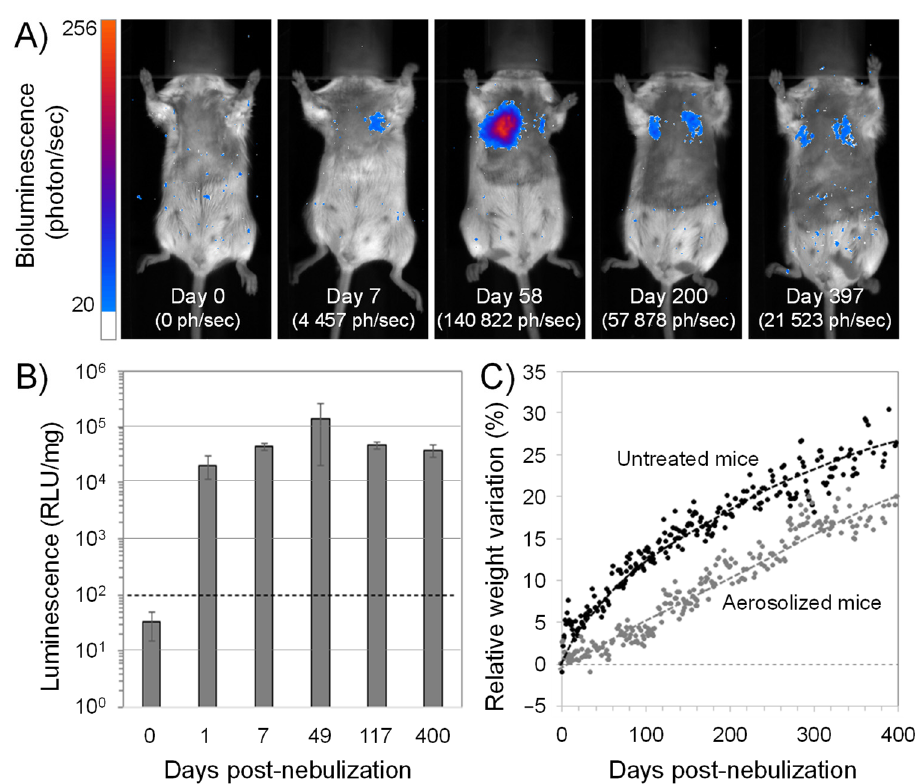
Figure 5. Long-term, longitudinal follow-up of mice following treatment with an aerosol of F20 + L (((CholP/DOPE 1/2 DP5K) + pGM144) CR2 PR2). Panel ( A ) shows representative images of in vivo bioluminescence captured before treatment and then 7, 58, 200, and 397 days after treatment. The color scale denotes bioluminescence intensity; it is set to display only signals above the background. For each mouse, luminescence intensity is indicated. See Figure S4 for more pictures and information. In panel ( B ), luciferase expression was determined in lung homogenates collected before treatment and then 1, 7, 49, 117, and 400 days after treatment (mean +/ − SD with n = 3–5 mice at each time point). The dashed horizontal line specifies the positivity threshold in luminescence. Panel ( C ) recapitulates the body weight variations of the mice during the experiment; each dot corresponds to the mean in either a control group ( n = 5 mice) or a treated group ( n = 3–20